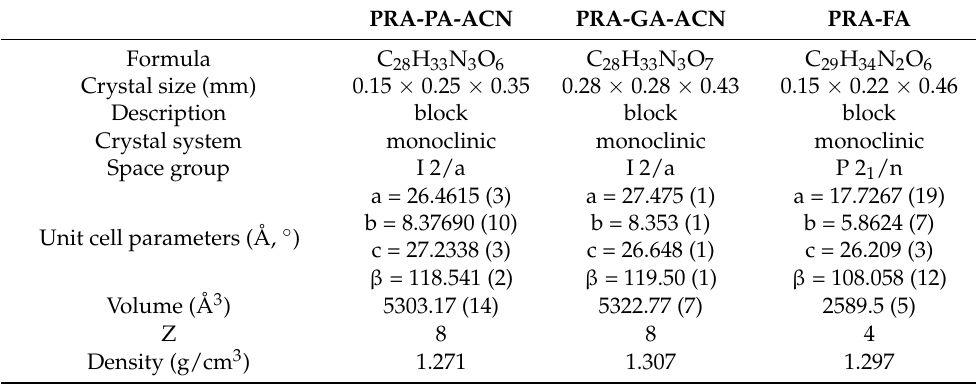
Table 1. Crystal cell parameters and structure refinement of the